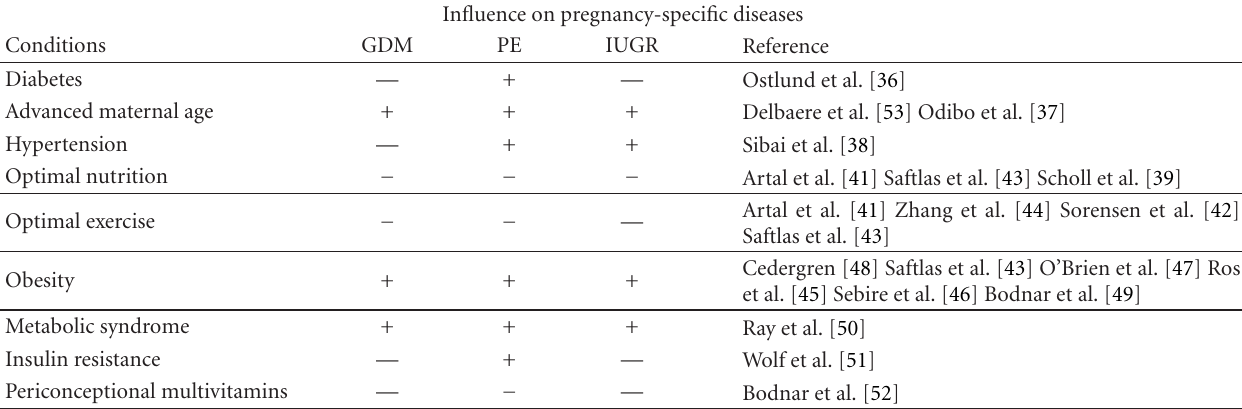
Table 2: E ff ects of metabolic conditions on pregnancy-specific diseases (GDM: gestational diabetes mellitus; PE: preeclampsia; IUGR: In- trauterine growth restriction; − : reduced risk; +: increased